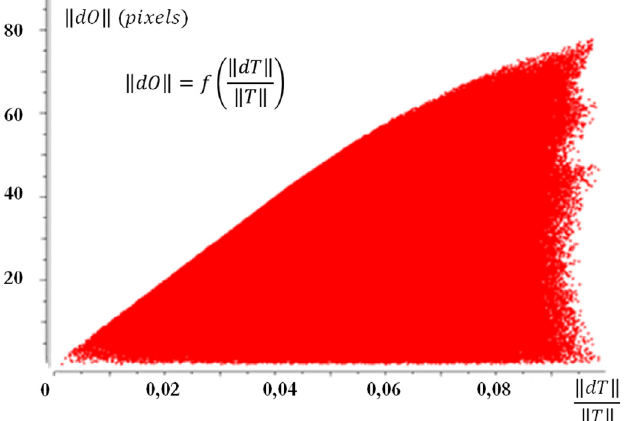
Fig. 22. Linear system error ampli fi cation by Monte-Carlo methods.